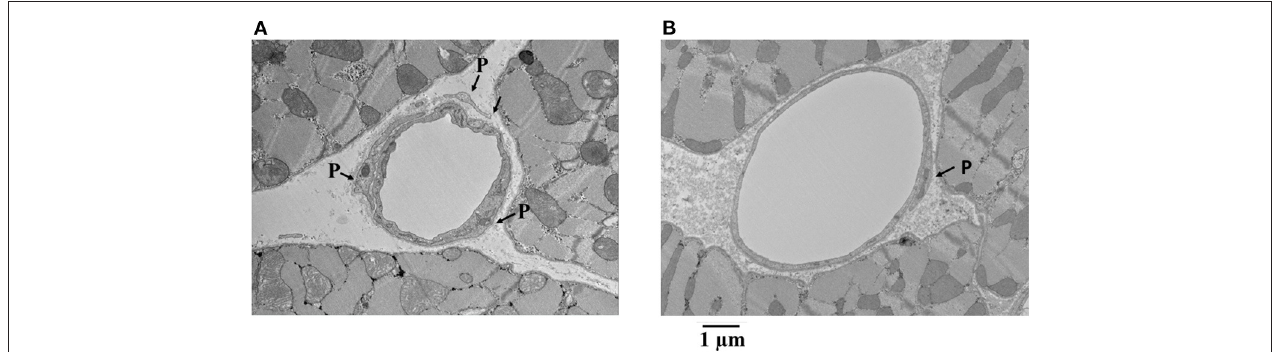
FIGURE 7 | Examples of capillaries and pericytes (P) from the endocardium of a dog where MVR decreased from 2.58 to 1.28 mmHg · (mL · min) − 1 and CDP decreased from 55 to 40 mmHg with adenosine infusion. Note the irregular appearing smaller lumen in (A) where adenosine was not given compared to the smoother and larger lumen where adenosine was given (B) . In both instances, pericyte processes are